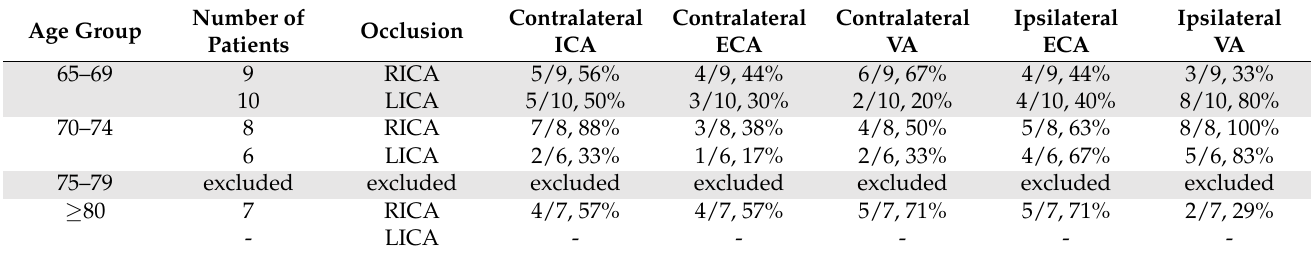
Table 5. Pathways of collateral circulation in patients with unilateral ICA occlusion.